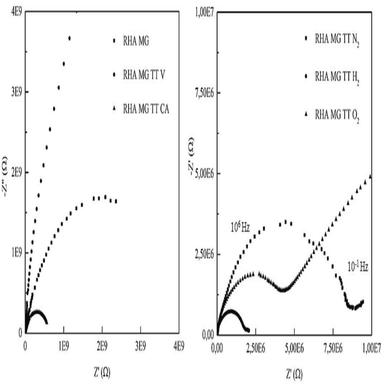
Nyquist diagrams of heat treatments derived from RHA MG.